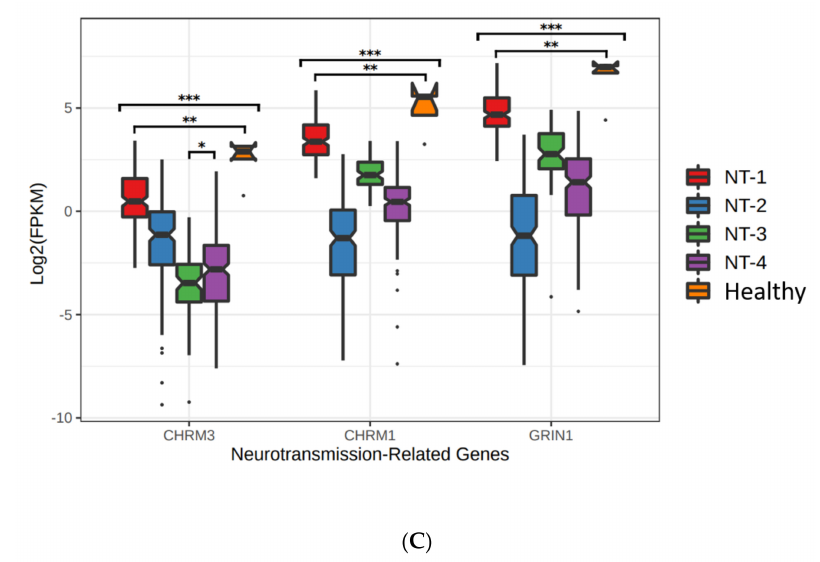
Figure 4. ( A ) Upset plot representing the differential gene cluster-to-cluster expression analysis. A total of 232 genes were differentially expressed in NT-1-4 gliomas (up- or downregulated). Each row represents a specific cluster comparison; columns represent the number of common genes. Each linked black point represents intersecting genes between glioma clusters. ( B ) GABA-, glutamate- and calcium-related gene expression profiles for NT-1-4 gliomas. Average normalized expression was performed with the DESeq2 v1.26.0 R package. Healthy samples ( n = 5) were also included in this analysis. Genes were ordered by descending expression levels of the healthy samples. ( C ) CHRM1, CHRM3 and GRIN1 gene expression levels in NT-1-4 gliomas. Expression levels are presented in log2 FPKM for 3 intersecting genes from all 6 cluster-to-cluster expression analyses (* p < 0.05, ** p < 0.001 and *** p < 0.0001).